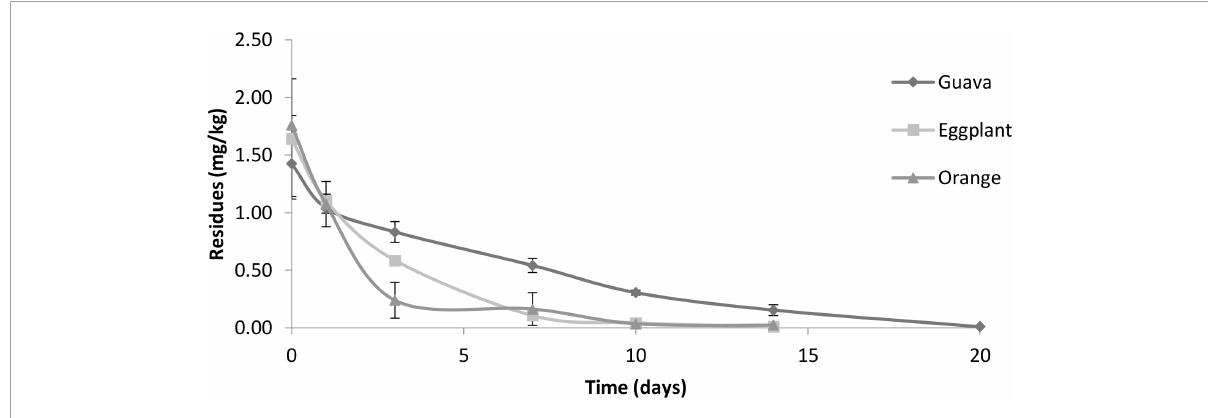
FIGURE6 The dissipation behavior of fenpyroximate in eggplant, guava, and orange fruits. The residue concentrations (mg/kg) are expressed in semi-logarithmic scale.